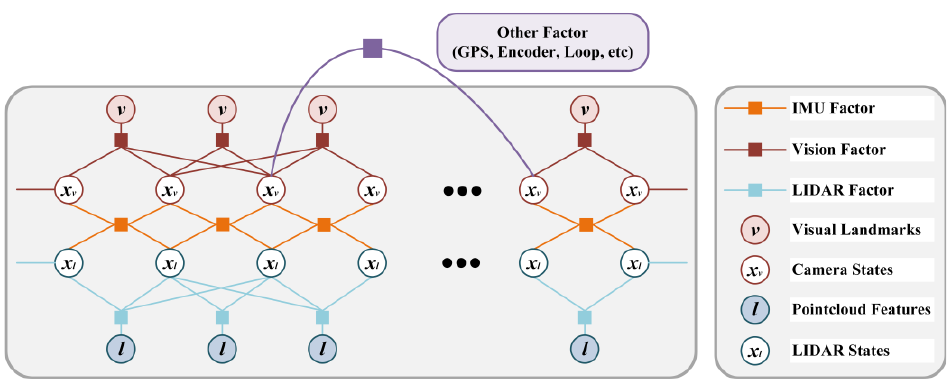
Figure 5. The factor graph for tightly coupled